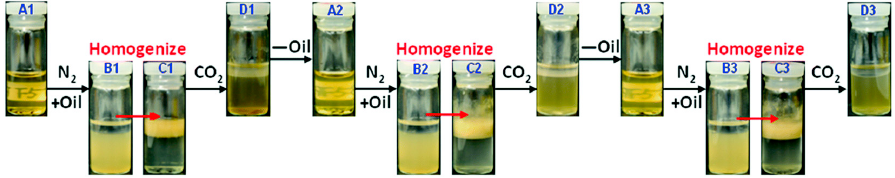
Figure 8. Three cycles of the N 2 /CO 2 -triggered emulsified/demulsified process of lignin-g-PDEAEMA Pickering emulsion. Reprinted with permission from [94]. Copyright 2014, Royal Society of Chemistry.